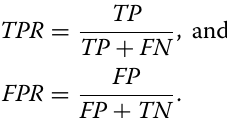
only utilizes the log power spectra, as the baseline of the evaluation.